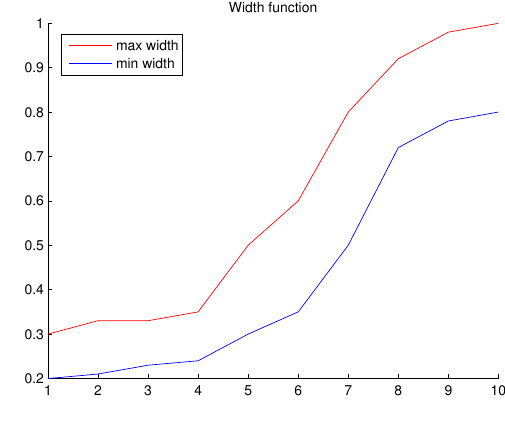
Figure 7: Fingers brunch width